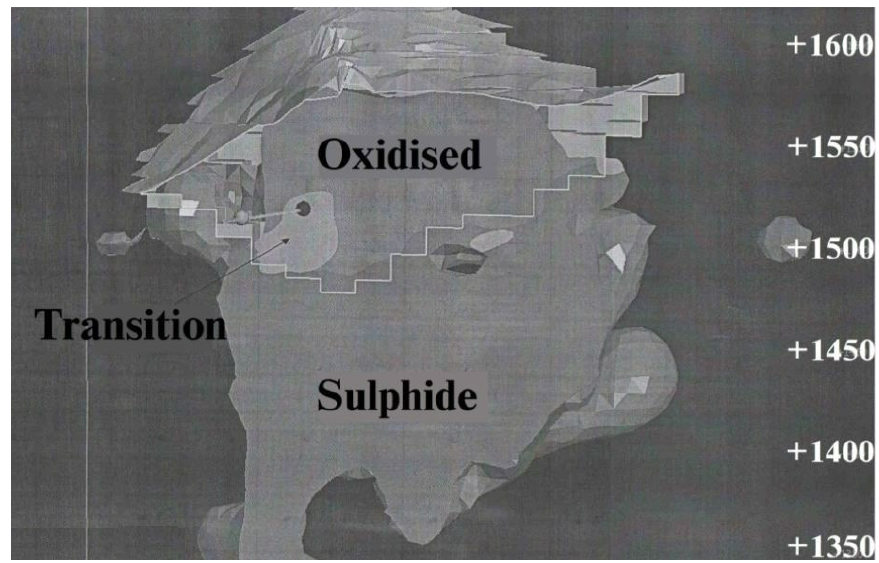
Figure 11. Scheme of oxidized primary sulfide and mixed ores’ location of Chovdar field [70]. The indicated and inferred mineral resources for the oxidized part of the deposit are estimated at 4.4 Mt. For the sulfide phase of the deposit, the resource estimate is 13.7 Mt [69,70]. The cut-off-grade for the mineral resource reporting is set at 0.5 gr/tonne of gold. The exploration results resulted in exploiting the mineralization in two phases. Phase One is to exploit the oxidized mineral reserves from an optimized open pit, and Phase mineralization and sulfide mineralization